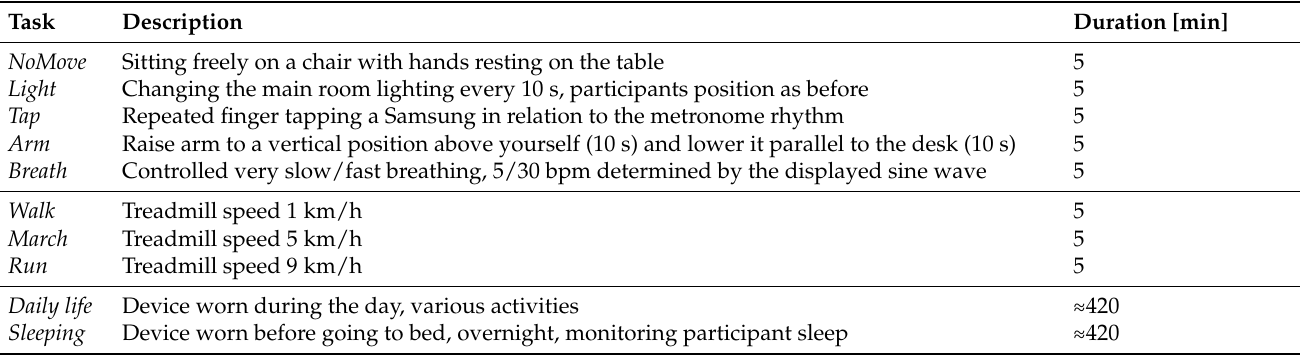
Table 1. Measurement protocol with the activity clusters, task descriptions and task